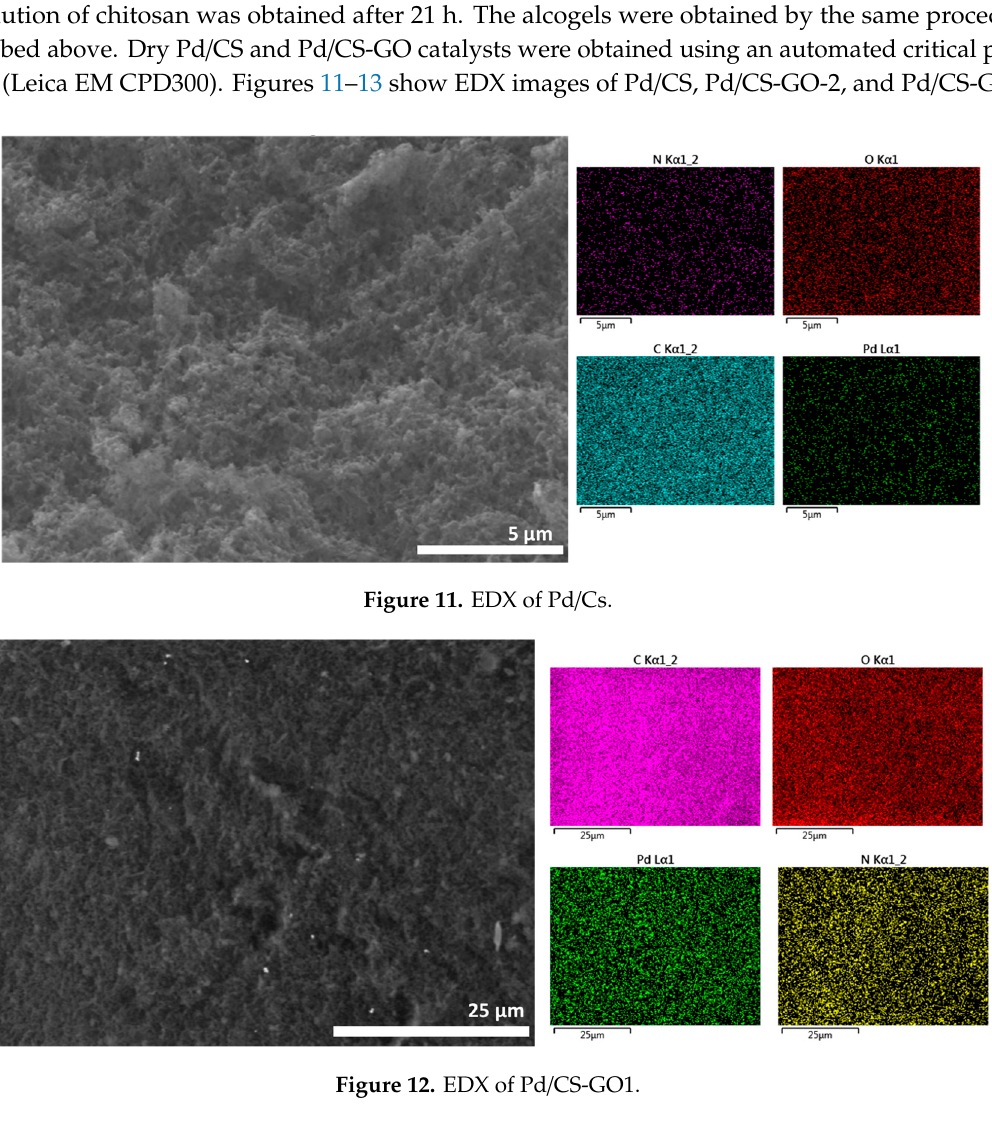
Figure 13. EDX of Pd/CS-GO3. 3.2. Catalytic Activity Test The experiments were conducted in a 130 mL reaction vessel under steady stirring (250 rpm) at the appropriate temperature ranging from 25 to 60 °C. The vessel was sealed and the internal air was degassed three times using argon. Typically, 50 mg of the catalyst (2.5 wt% of Pd) was added to a 10 mL of 1 M ammonium formate solution (10 mmol of ammonium formate). For comparison, the catalytic activity of a commercial 10% Pd/AC sample was also tested. The amount of Pd present in the reaction in the case of Pd/CS-GO2 used was 11.75 µmol in all experiments. H 2 and CO 2 generation was followed by analyzing the gases on the headspace using an Agilent 490 MicroGC having two channels both with TC detectors and Ar as the carrier gas. One channel has a MolSieve 5A column